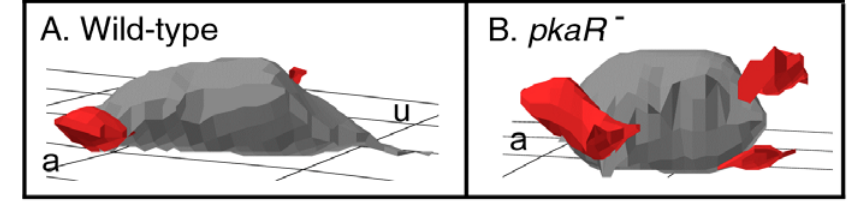
FIGURE 7. The major differences in cell shape between a wild type Dictyostelium amoeba and a pkaR - cell in buffer is resolved by 3D-DIAS. Note the aberrant ovoid shape and formation of pseudopods off the substratum by pkaR - cells.